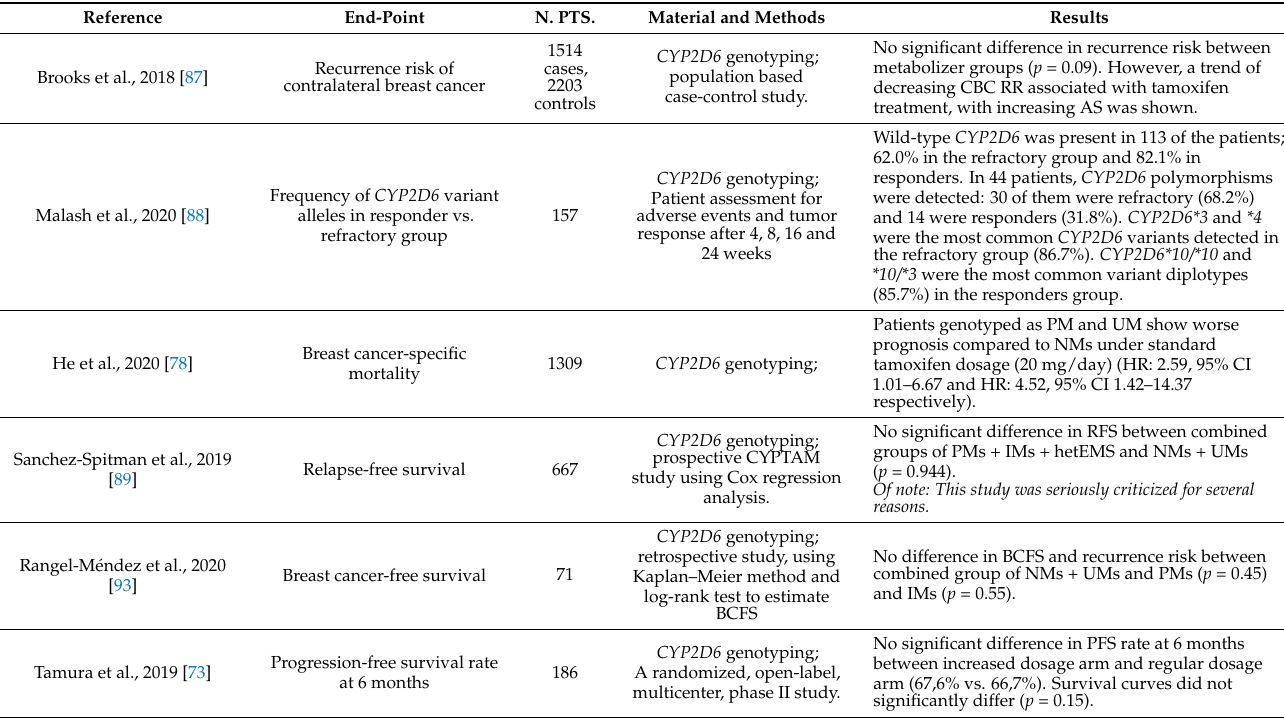
Table 3. Summary of described recent studies on CYP2D6 genotyping in relation to tamoxifen-related clinical